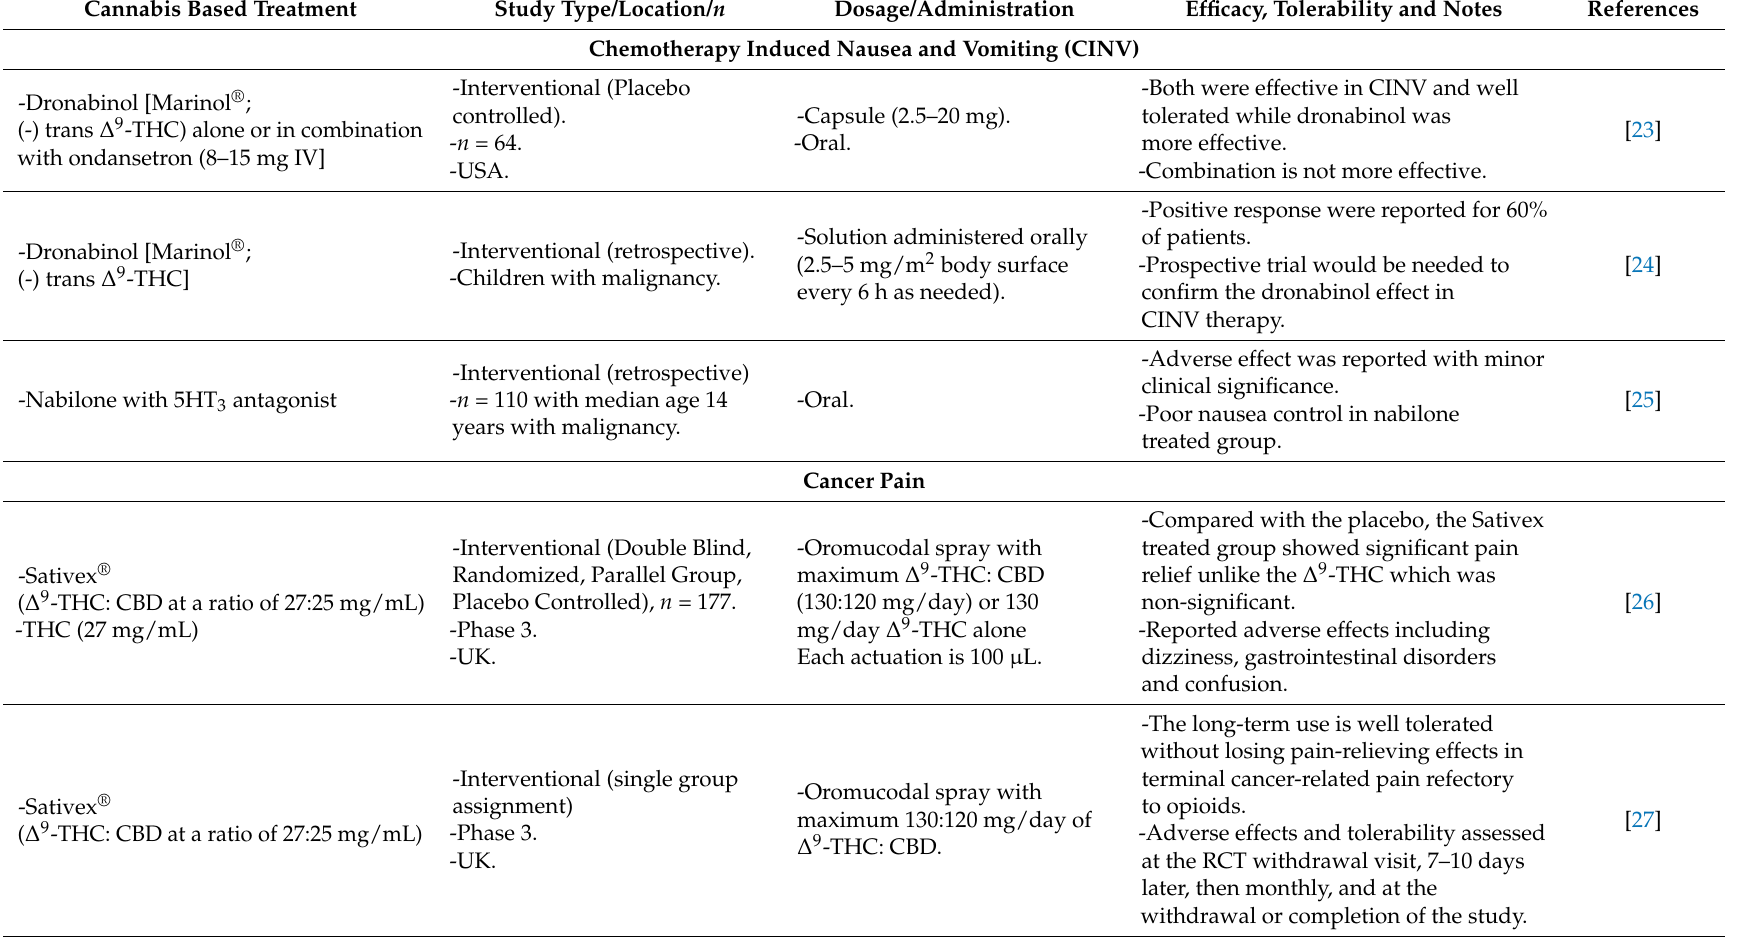
Table 1. Recent clinical studies of cannabinoids in oncology